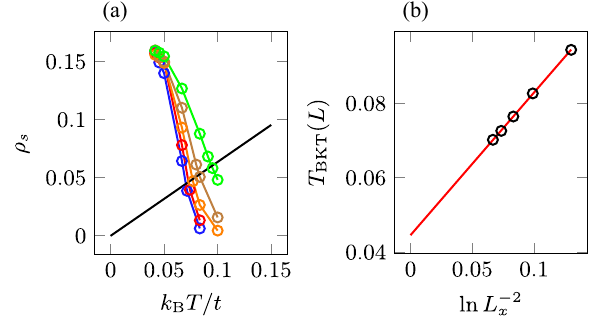
FIG. 19. Strategy for obtaining T for the parameters BKT U ¼ − 4 t , t ⊥ ≈ 0 . 28 t , and μ ¼ − 0 . 6533 t . In (a) an intersection L Þ , and (b) the thermodynamic of ρ and 2 T= π indicating T s BKT ð limit of T obtained through Eq. (D13). The aspect ratio is BKT L = 4 . chosen such that L y ¼ x